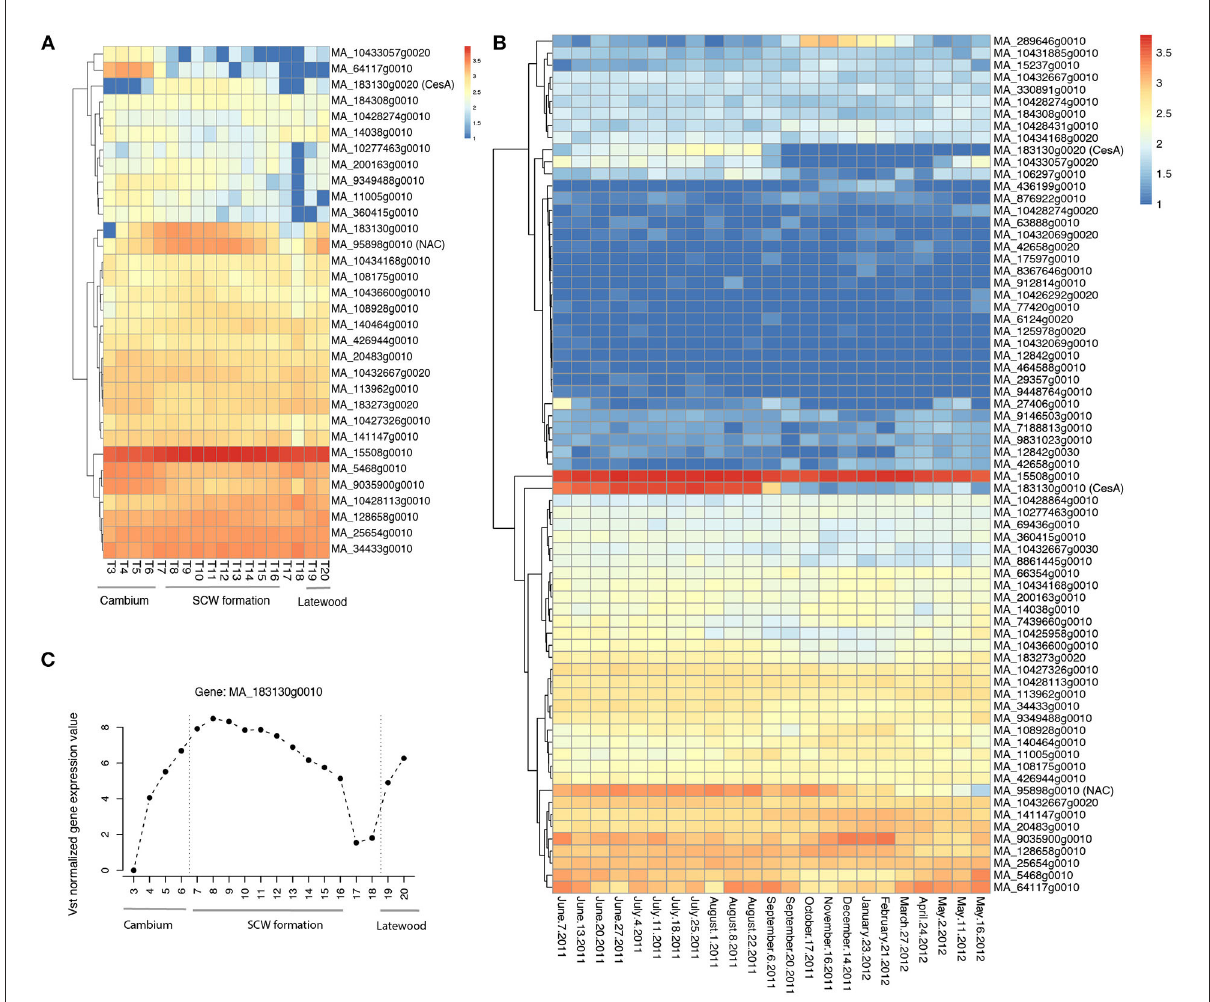
FIGURE5 Spatial and temporal expression pattern of the identified candidate genes in Norway spruce. (A) Heatmap of RNA-seq data from the different wood developmental zones of Norway spruce stem (tree 1; Jokipii-Lukkari et al., 2017); (B) Heatmap of RNA-seq data in a whole seasonal cycle for the xylem of Norway spruce; (C) The expression of the candidate gene MA_183130g0010 in Norway spruce (tree 1; Jokipii-Lukkari et al., 2017). Vst means variance-stabilizing transformation. The data used in (A–C) can be downloaded from the website (https://plantgenie.org). SCW is the secondary cell